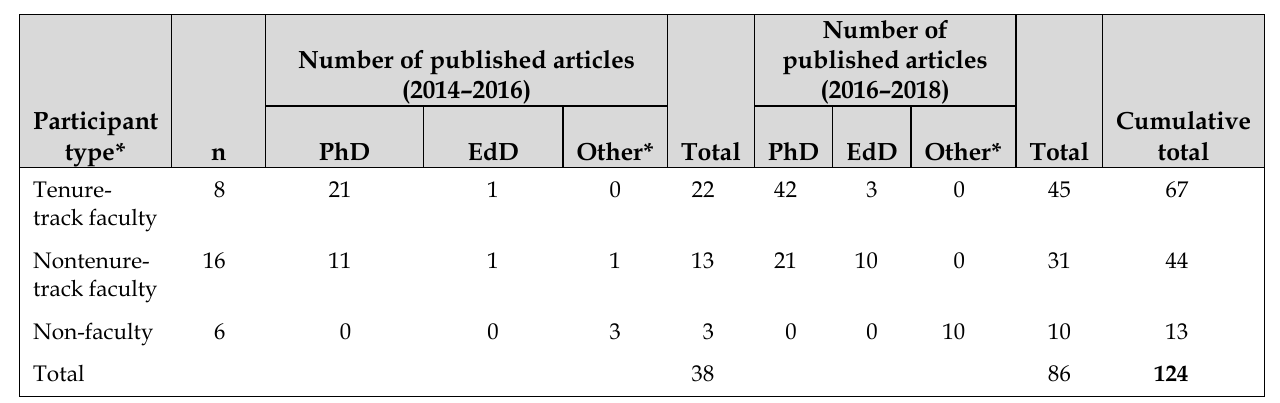
Table 1 Total number of articles published by faculty status and level of education (before and after the